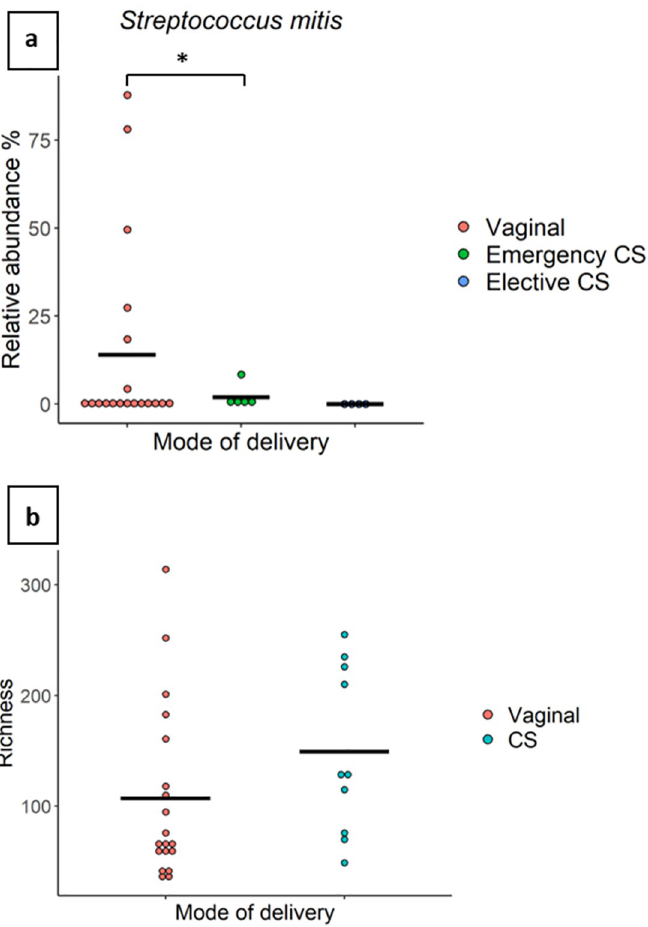
Fig 3. The relative abundance of Streptococcus mitis and bacterial richness are associated with the mode of delivery. (a) The relative abundance of Streptococcus mitis in milk from mothers who delivered vaginally (n = 19), via emergency caesarean section (n = 5), or via elective caesarean section (n = 4). The average value for each group is indicated with a line. (b) Richness of milk samples from mothers who delivered via caesarean section (n = 10) or vaginally (n = 19). � indicate significant